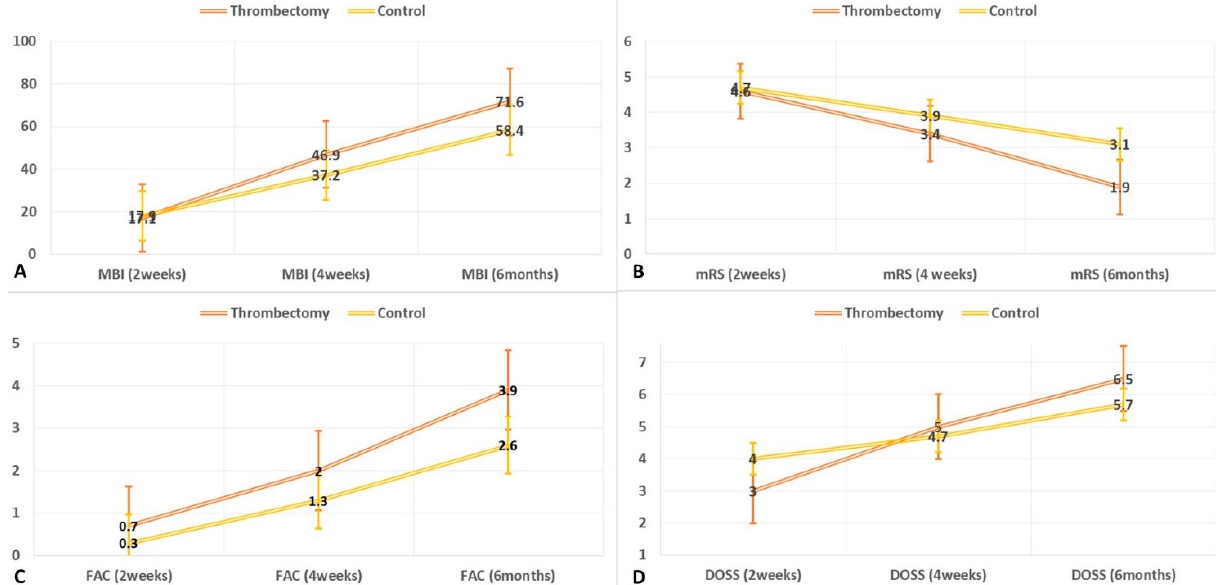
Figure 1. Functional recovery after thrombectomy. The MBI, mRS, FAC, and DOSS scores changed significantly according to group and time. The graph indicates the changes of the activities of daily living (( A ); modified Barthel Index, MBI, 0–100), handicap (( B ); modified Rankin Scale, mRS, 0–6), gait (( C ); functional ambulation category, FAC, 0–5), and eating (( D ); dysphagia outcome severity scale, DOSS, 1–7). The numbers represent mean values of each groups for each times, and bar lines represent standard deviation of each groups for each times.